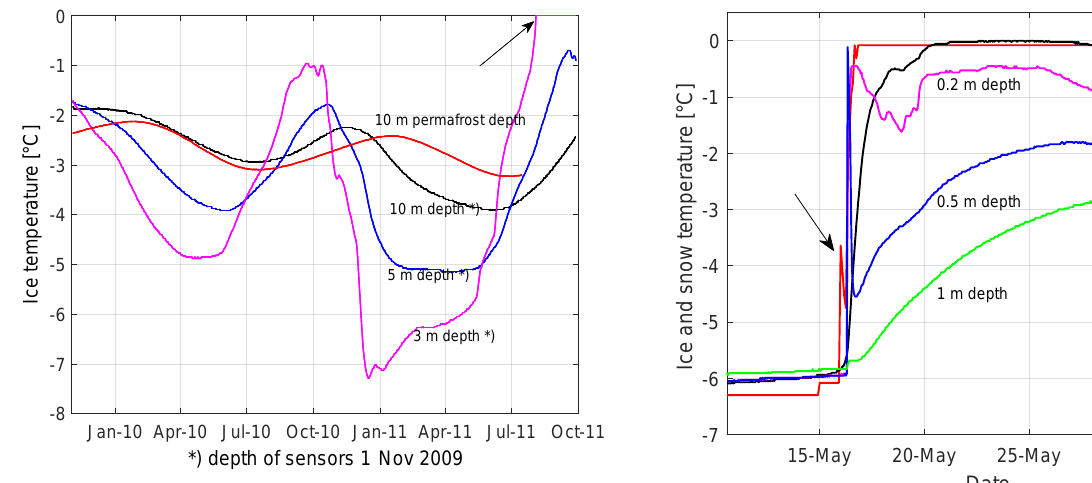
Figure 13. Temperature for November 2009–September 2011 in a 10m deep borehole in the Juvfonne ice patch (see Fig. 3a for posi- tion). The red line is the temperature at 10m depth in the P31 per- mafrost borehole 750m north from the ice patch (see Fig. 2 for loca- tion). Arrow points to the time when the sensor placed at 3m depth in autumn 2009 melted out. The entire thermistor string melted out in mid-September 2014.